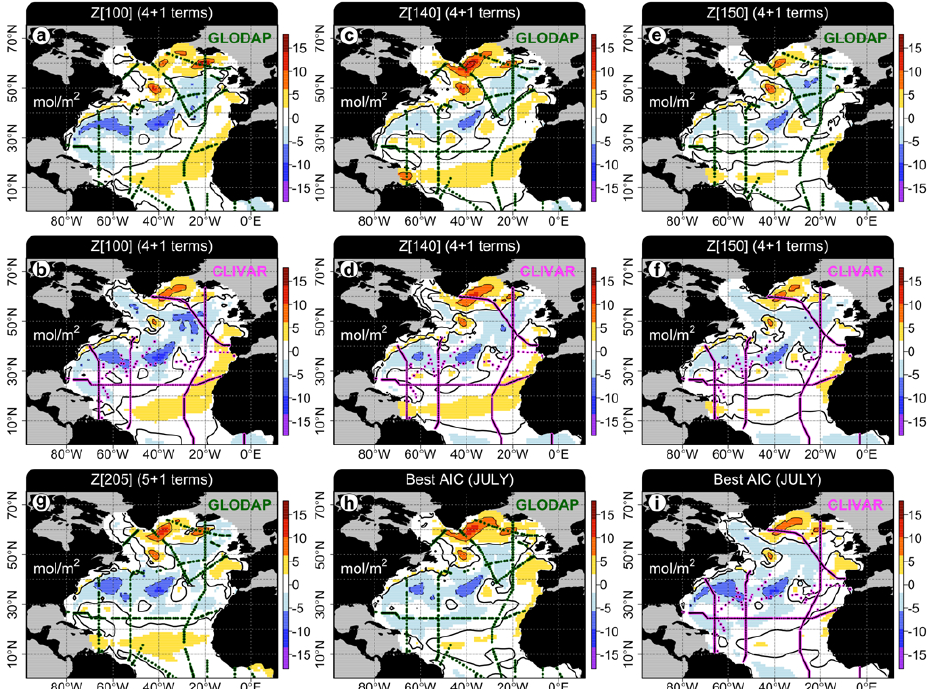
Fig. 12. Absolute errors in anthropogenic carbon column inventory changes between July 2005 and 1995 mapped from either the GLODAP (green) or CLIVAR (magenta) stations calculated from sampling networks that do not change in time ( 1C fixed solid (positive) contours are drawn in increment of 6molm − 2 . The thick lines marks the 0 contour. Results shown for models (a, b) Z 100 , (c, d) Z 140 , e, f: Z 150 , (g) Z 205 , and for cases when the “best AIC” models are selected for each layer and each time point (strategy 1) for (h) GLODAP and (i)